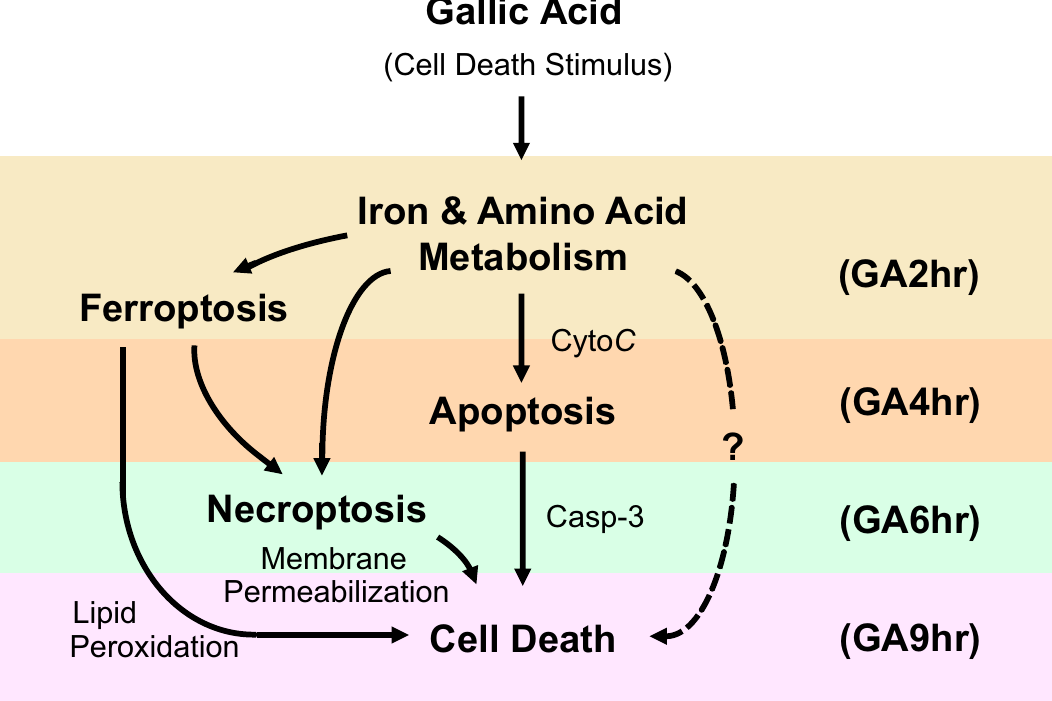
Figure 6. Proposed mechanisms of early (GA2hr), middle (GA4hr, GA6hr), and late (GA9hr) stages of gallic acid-induced cell death process. Dotted line indicates the unidentified cell death pathway(s) triggered by gallic